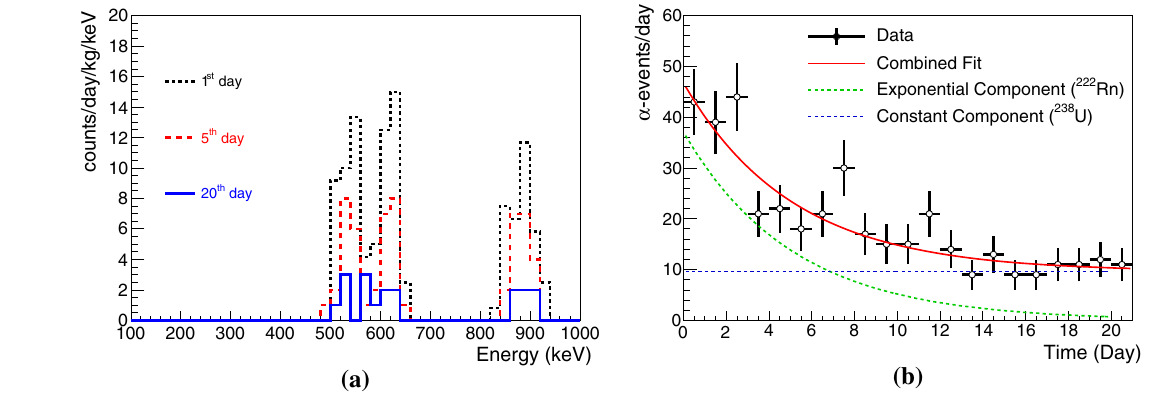
Fig. 4 a Energy spectra of α -particles originating from the 70mL PTFE cell at different times. The histogram labeled “1st day” is when the 70mL cell was first assembled while that labeled 20th day is 19 days later. The α -induced events are selected based on pulse shape dis- crimination criteria. b The number of measured α -events as a function